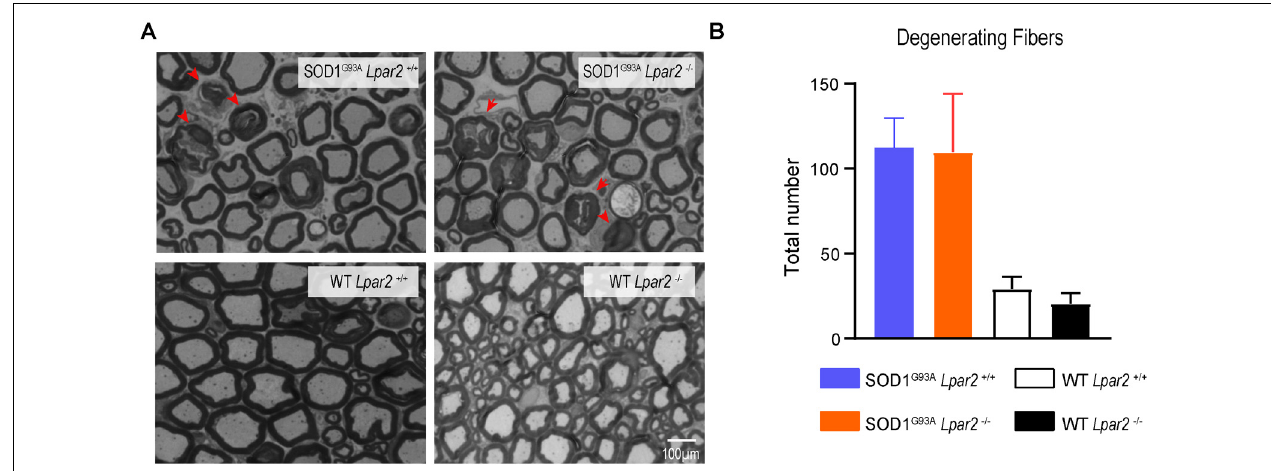
FIGURE 6 | Lpar2 deletion does alter Wallerian degeneration of motor axons in SOD1 G93A mice. (A) Representative cross-section images of the spinal nerve ventral root (L4) stained in toluidine blue. Note the presence of fiber with disrupted myelin sheaths the motor roots of ALS mice (arrowhead). (B) Graph showing the quantification of fibers with some signs of myelin degeneration at 16 weeks of age in male mice ( n = 3 SOD1 G93A Lpar2 − / − , n = 5 SOD1 G93A Lpar2 +/+ , n = 4 WT LPA 2 − / − , n = 3 WT Lpar2 +/+ ). Two-way ANOVA, Bonferroni’s post hoc test. Data are presented as mean ± SEM.